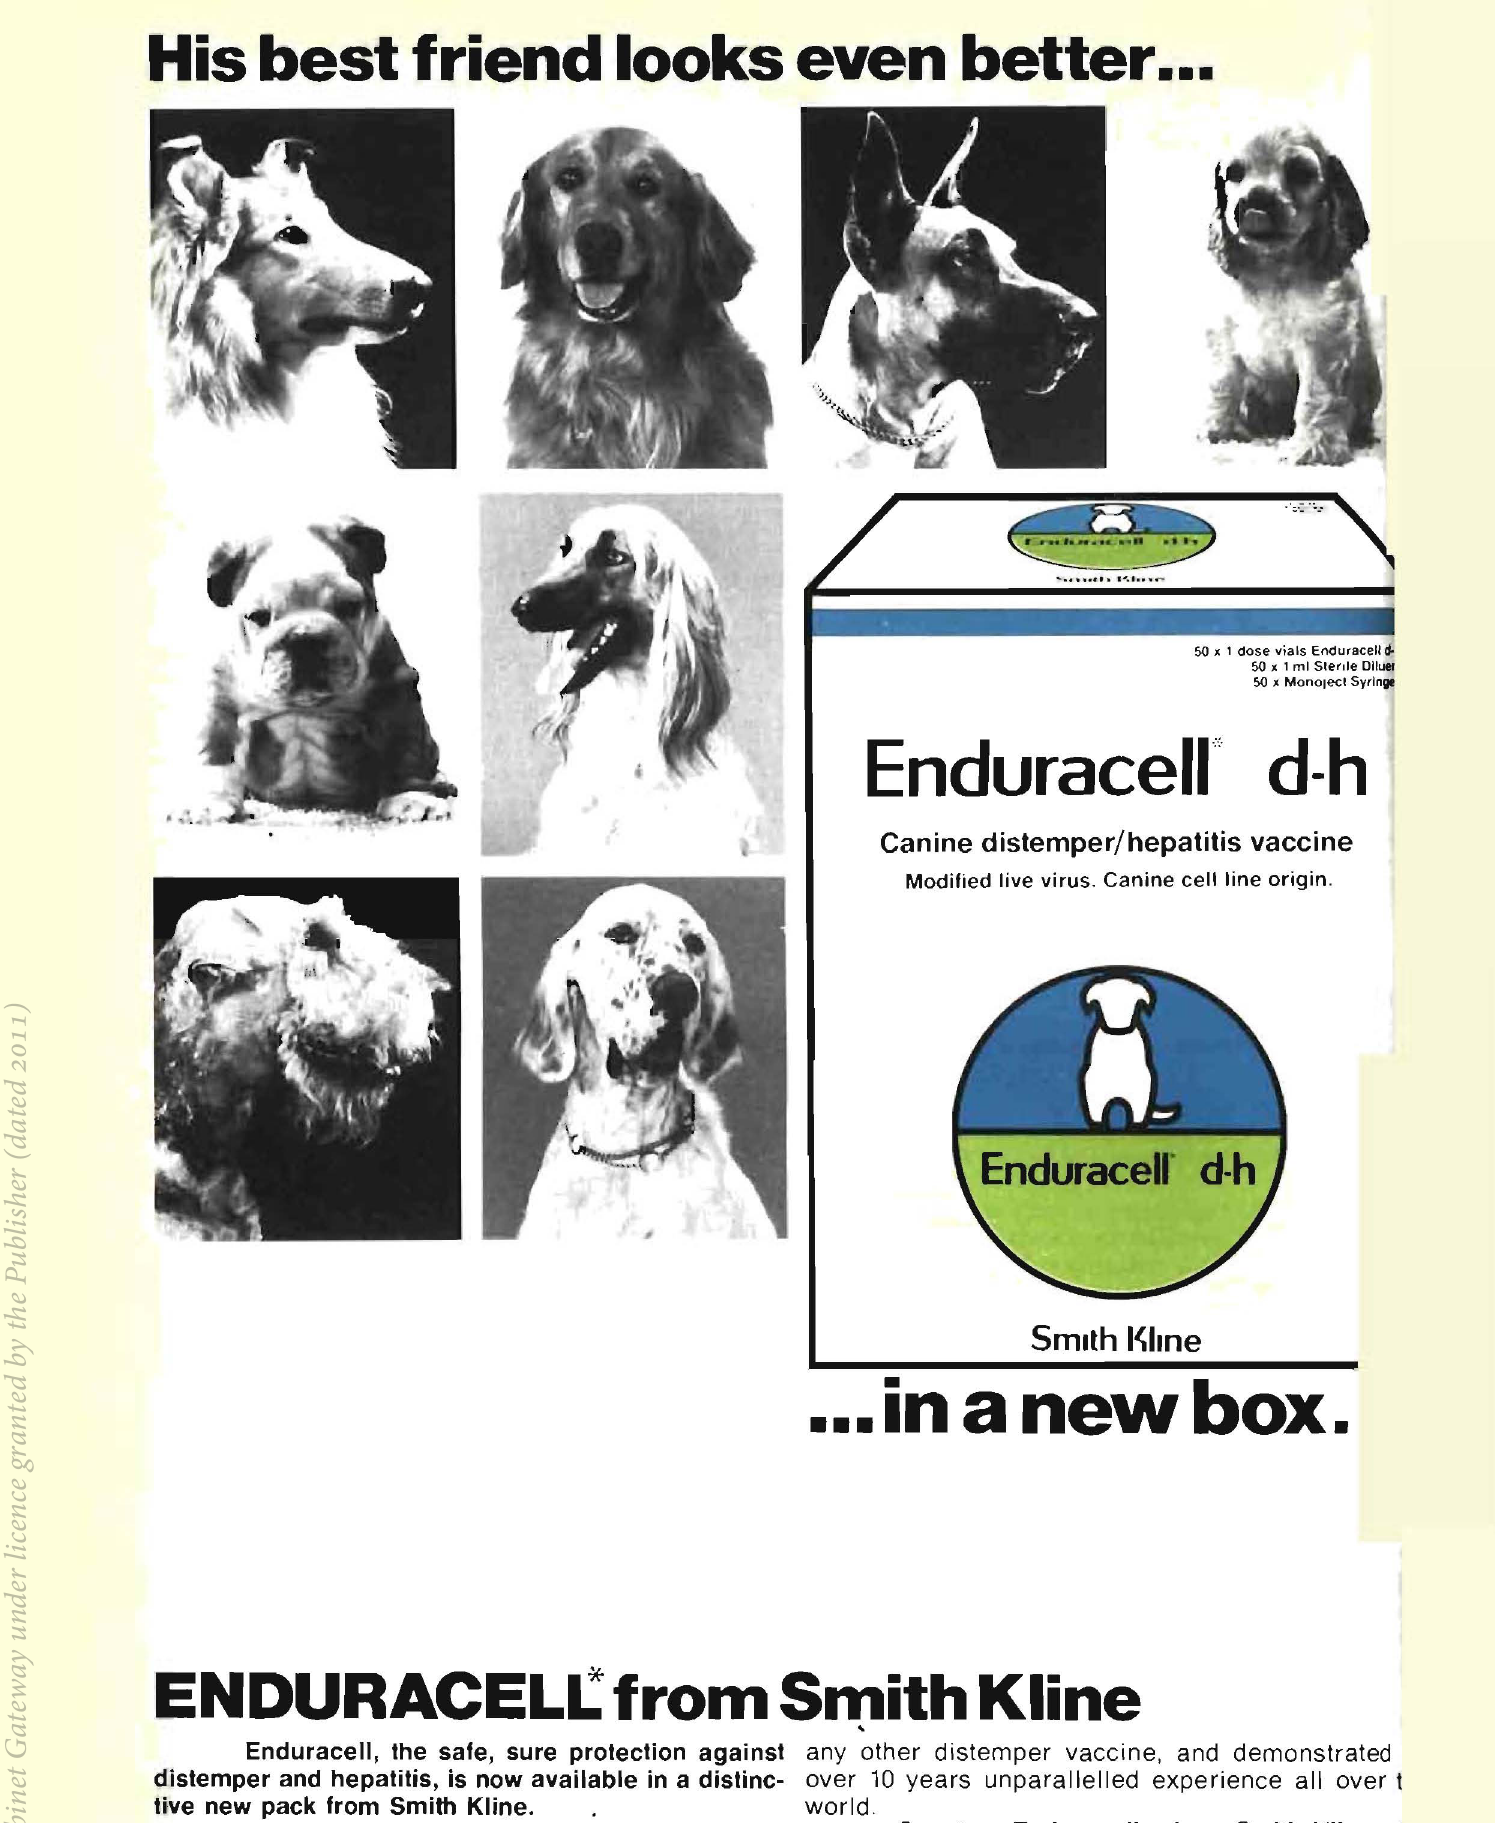
ENDURACELC frol11 Sl11ith